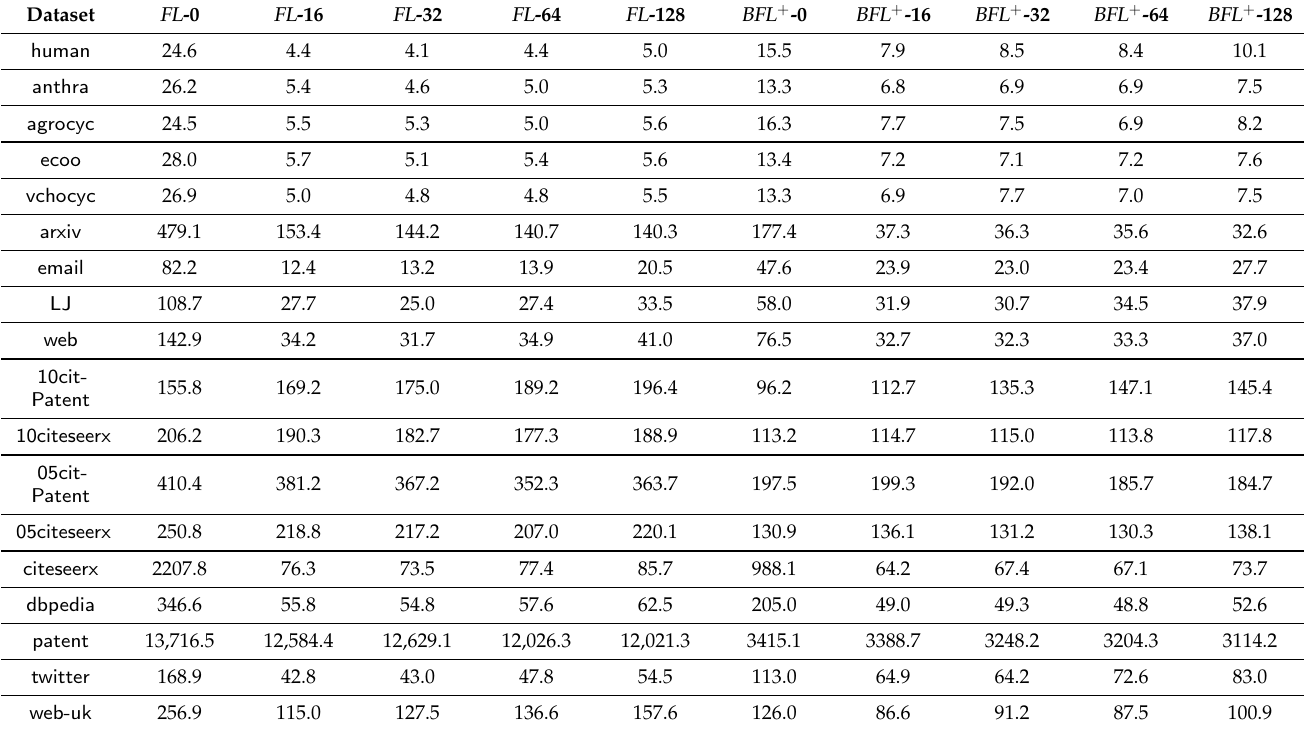
Table 6. Comparison of the query time